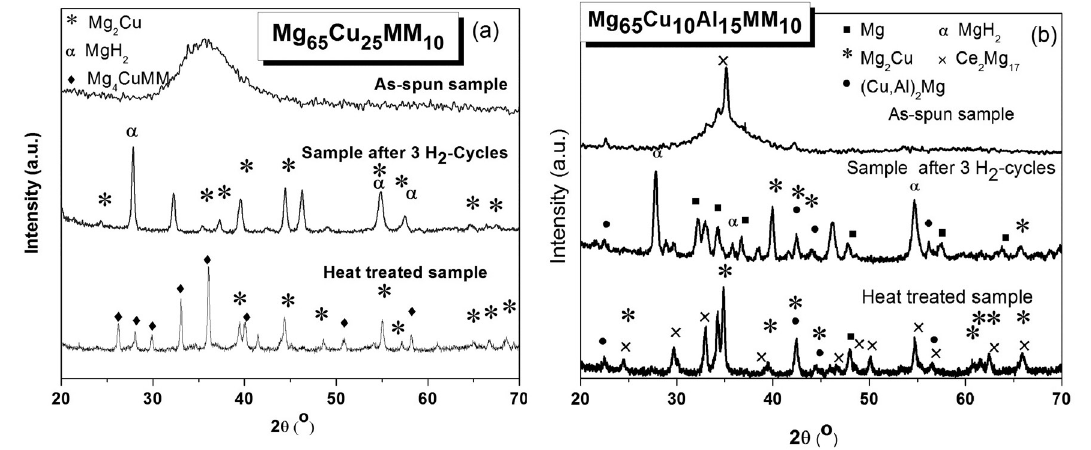
Figure 3: X-ray diffractograms of the as-spun, after three cycles of hydrogen absorption-desorption and of the heat treated samples in a continue heating up to 360ºC of the alloys: (a) Mg hydrogen absorption-desorption cycles are not present, which suggests those could correspond to an